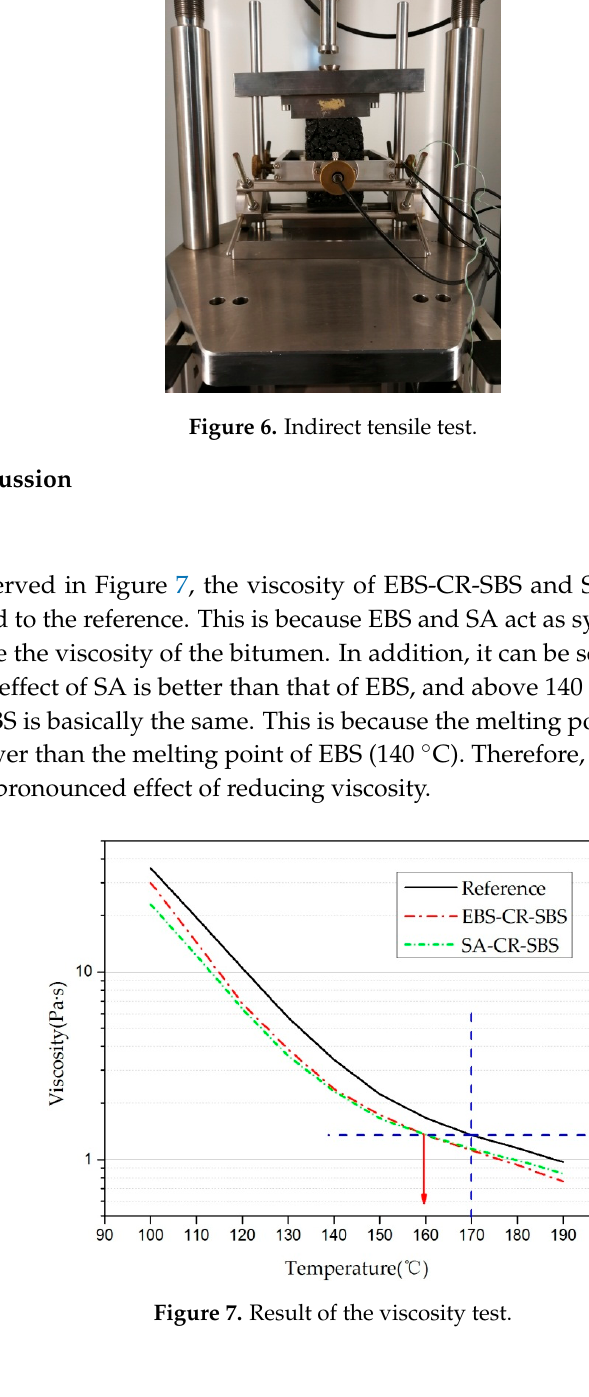
Figure 5. The creep test.